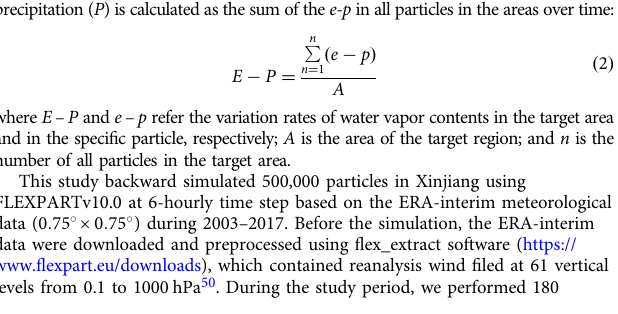
backward simulations from day 1 to day 10 at 6-hourly time step for every month. Each simulation result was used to approximately re fl ect the water vapor transport for each month. All trajectories extracted from the simulation results were clustered as 20 trajectories during 2003 – 2017 using the k -means cluster method 50 . Further, to re fl ect the monthly patterns of variations in trajectories, based on the monthly mean of particle locations in 2003 – 2017, monthly clustered trajectories had been calculated using the k -means cluster method as well 51 . Since the water vapor content in a particle was recharged or released along the trajectory, the variation in the transport route could not represent the contribution of water vapor from the source region to the target region 52 . Thus, we fi rst classi fi ed the potential source regions by the continent and ocean boundaries, which included Asia (AS, excluding Xinjiang), Europe (containing Russia, EU),